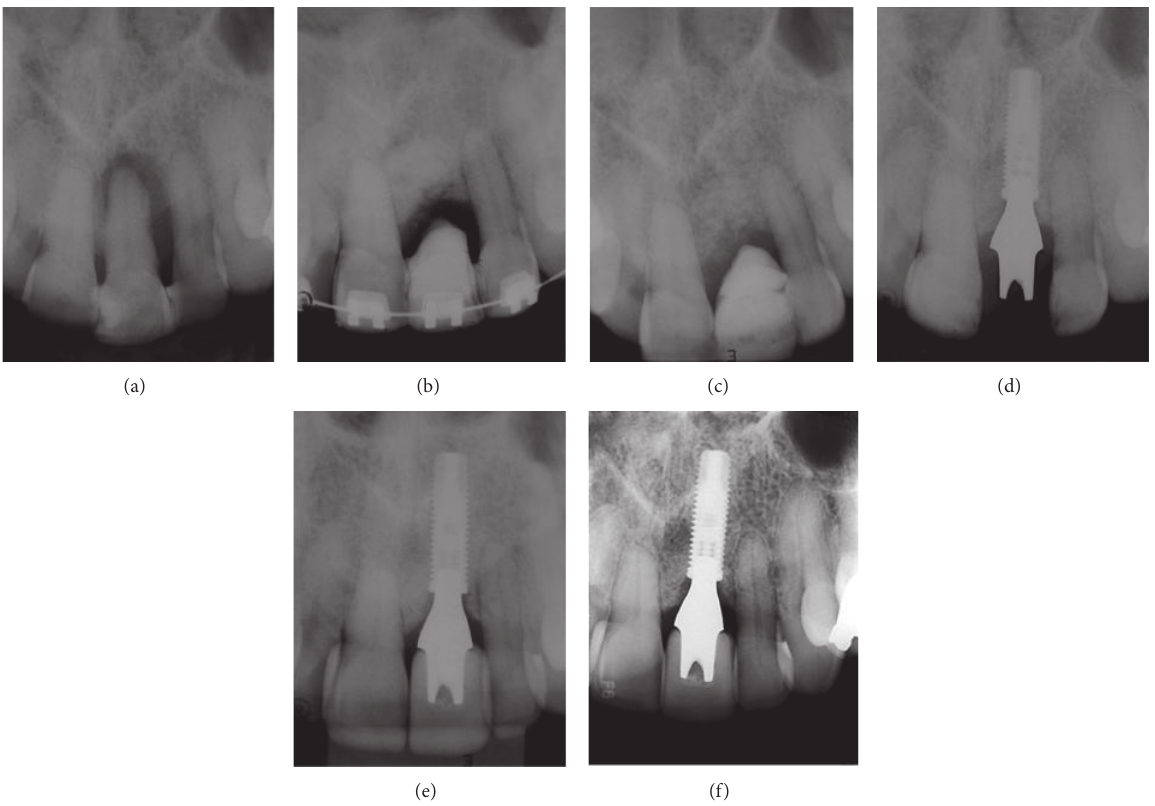
Figure 14: 6-year follow-up periapical radiographies. (a) Initially; (b) after bone grafting and GBR and beginning of orthodontic treatment; (c) after orthodontic treatment; (d) immediate implant placement; (e) after prosthesis installation; (f) 6 years